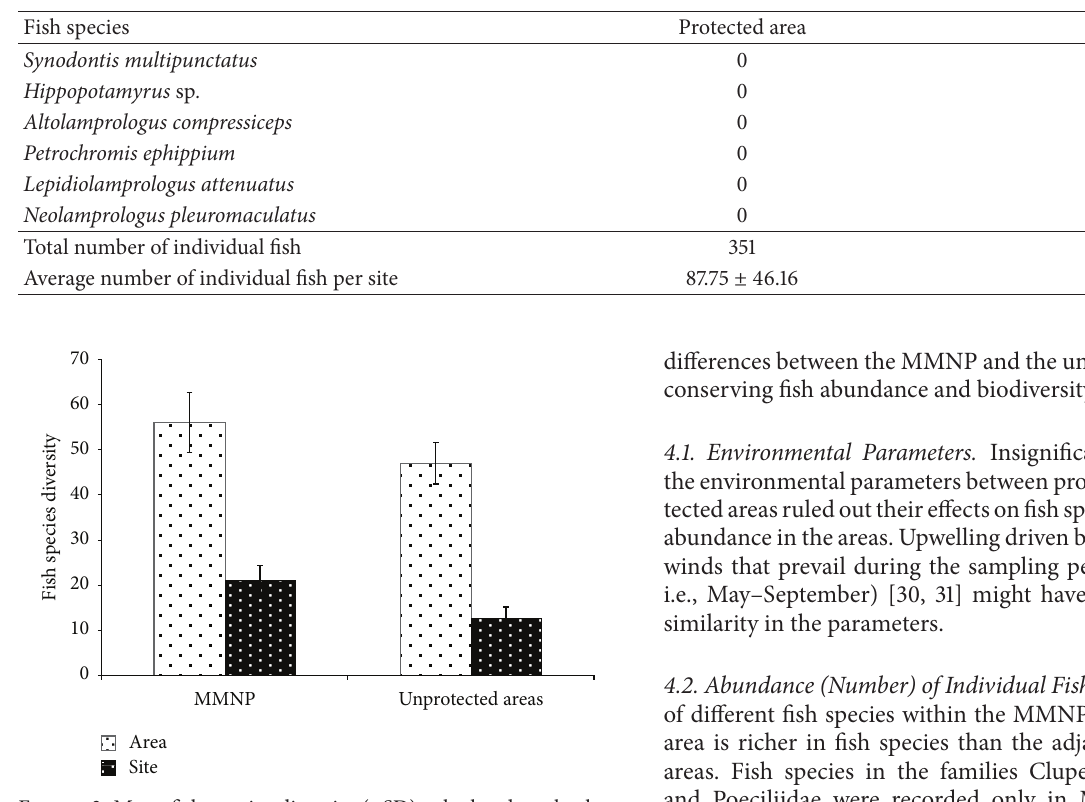
Figure 3: Mean fish species diversity ( ± SD) calculated as absolute species turnover in protected area (MMNP) and unprotected areas (Buhingu and Sibwesa) in Lake Tanganyika, Tanzania, during 2008 gillnet